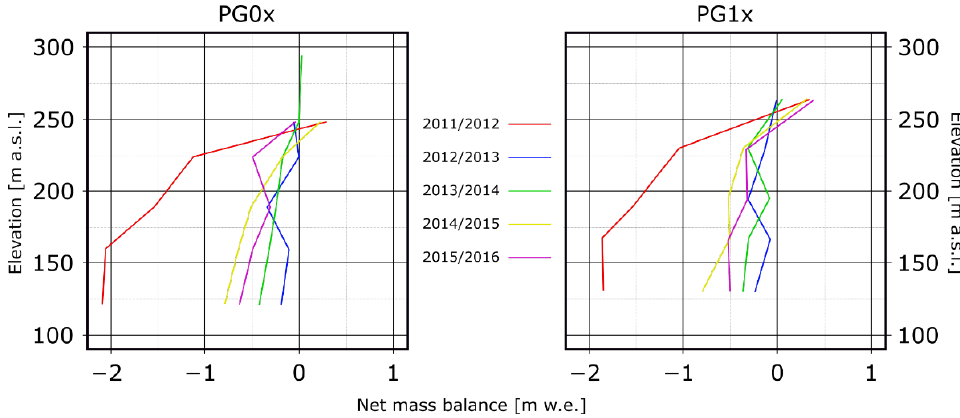
Figure 8. Specific summer, winter and net mass balances (bs, bn, and bw, respectively) in m w.e. derived from the mass balance stake observations collected at transects PG0x and PG1x from 2010 to 2016, based on data from Falk et al. [17].